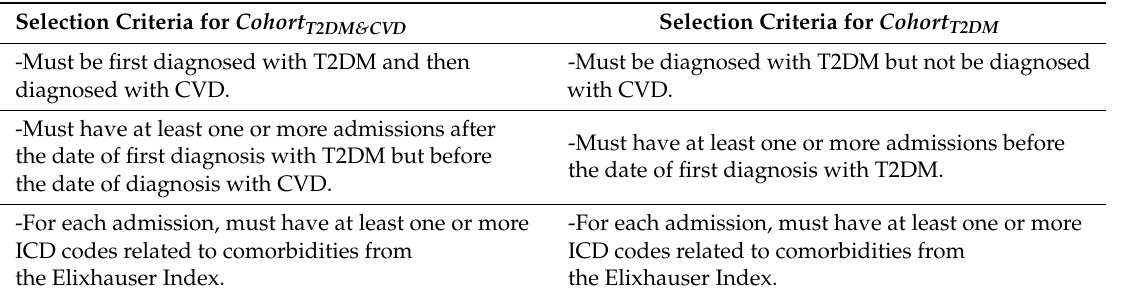
Table 3. Selection criteria for both